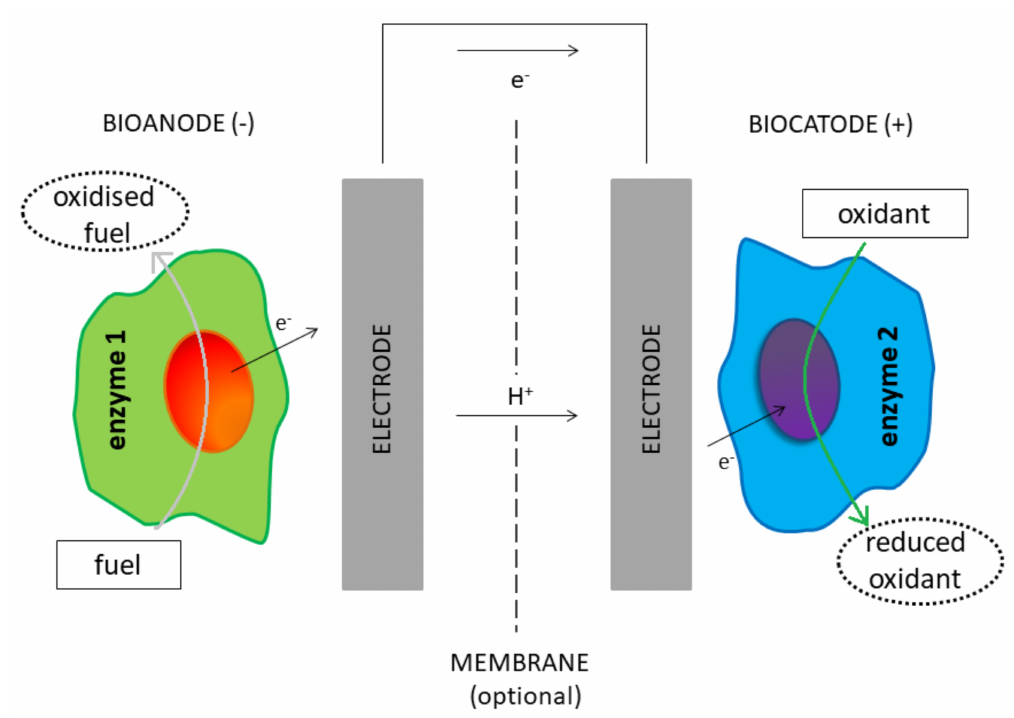
Figure 1. Schematic representation of an enzymatic biofuel cell (EFC)